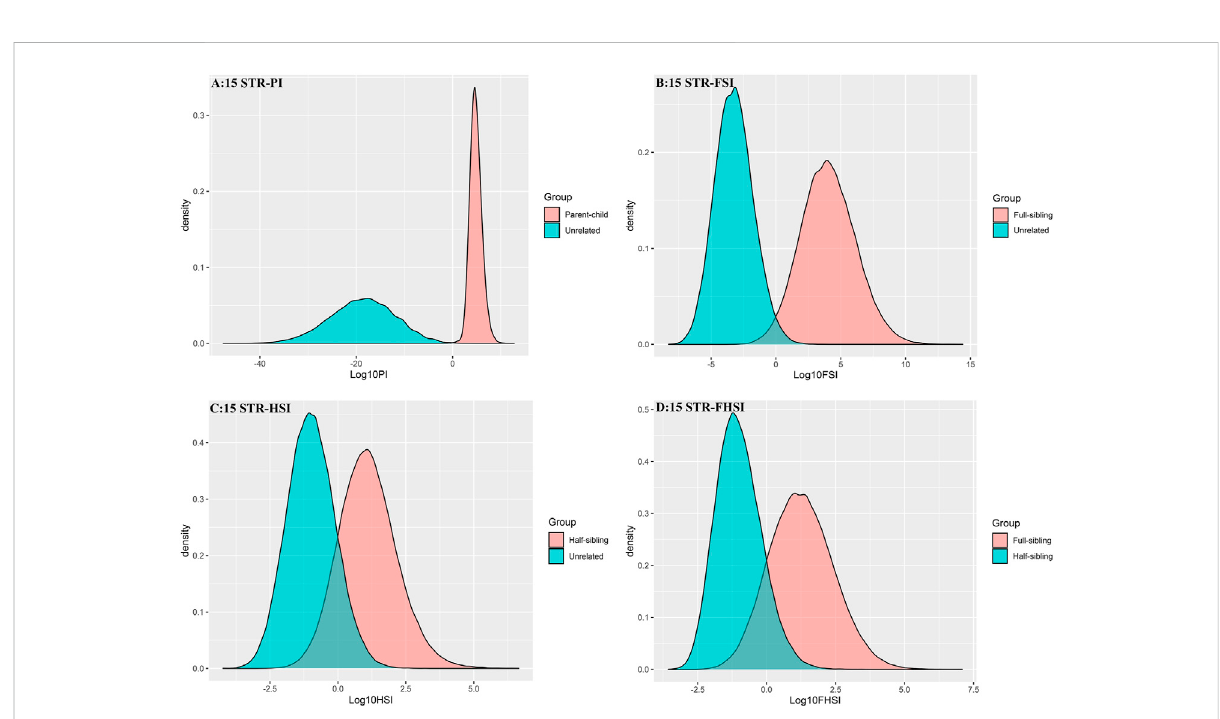
FIGURE 2 The distributions of Log 10 of PI, FSI, HSI, and FHSI based on the data of 15 STR loci. (A) PI; (B) FSI; (C) HSI; (D) FHSI.